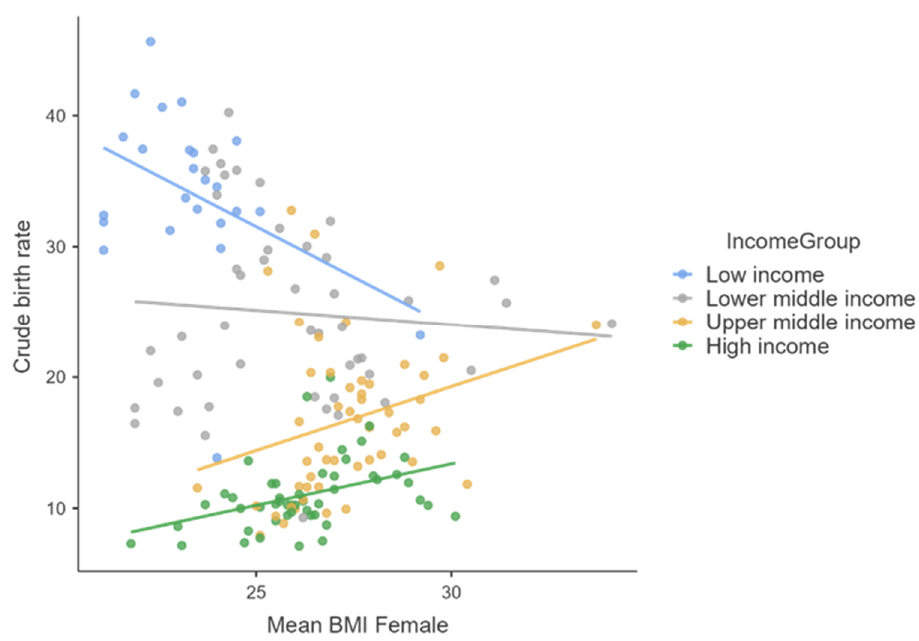
Figure 3. The correlation between mean BMI Female and the crude birth rate .